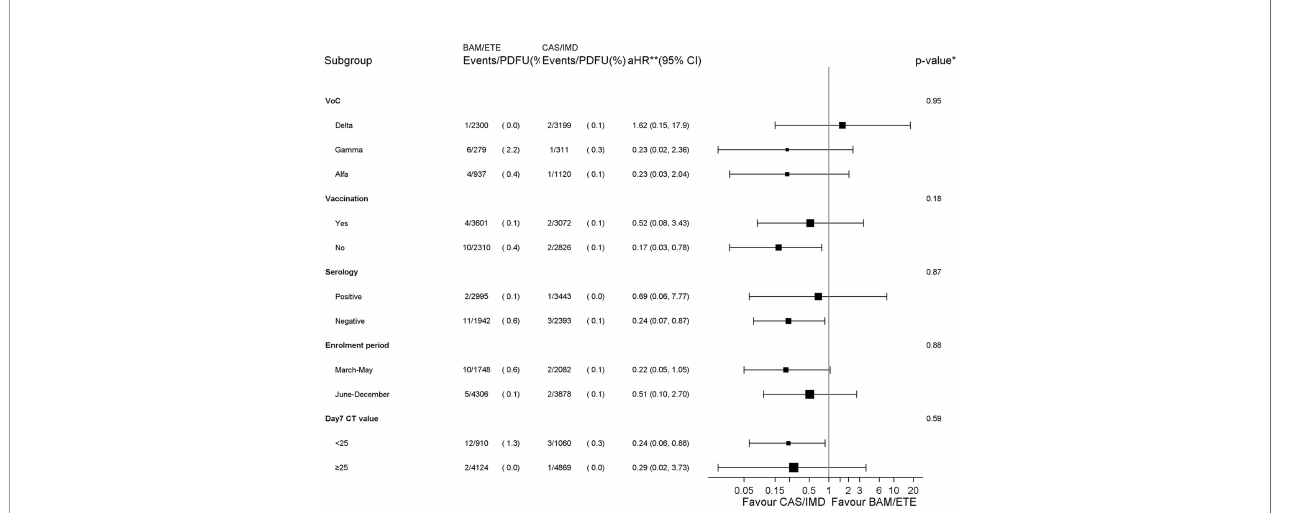
FIGURE 4 | Forest plot of the effect of the intervention by subsets - Primary endpoint. *p-value corresponds to the test for interaction between intervention and each subgroup unadjusted for multiplicity. **aHR1 – (vaccination, serology and CT strata) adjusted for calendar month and VoCs; **aHR2 – (VoCs stratum) adjusted for MASS score because of a positivity issue leading to abnormally high weights in the stratum of participants infected with the Delta VoC; **aHR3 – (enrolment period stratum) adjusted for MASS score and VoCs. PDFU, person days of